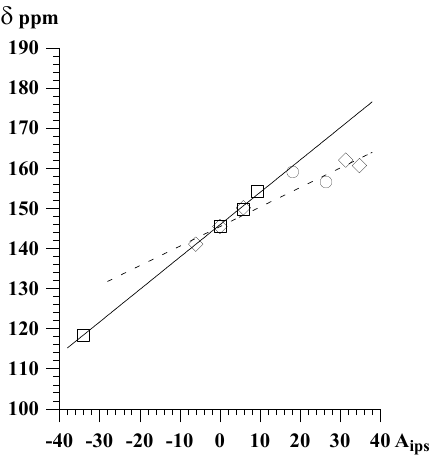
Figure 1. Correlation of chemical shifts of carbon atoms bonded to a substituent in 2-substituted pyrazine derivatives with the A parameters i (cid:133) - in CDCl solutions, 3 (cid:123) - in DMSO solutions